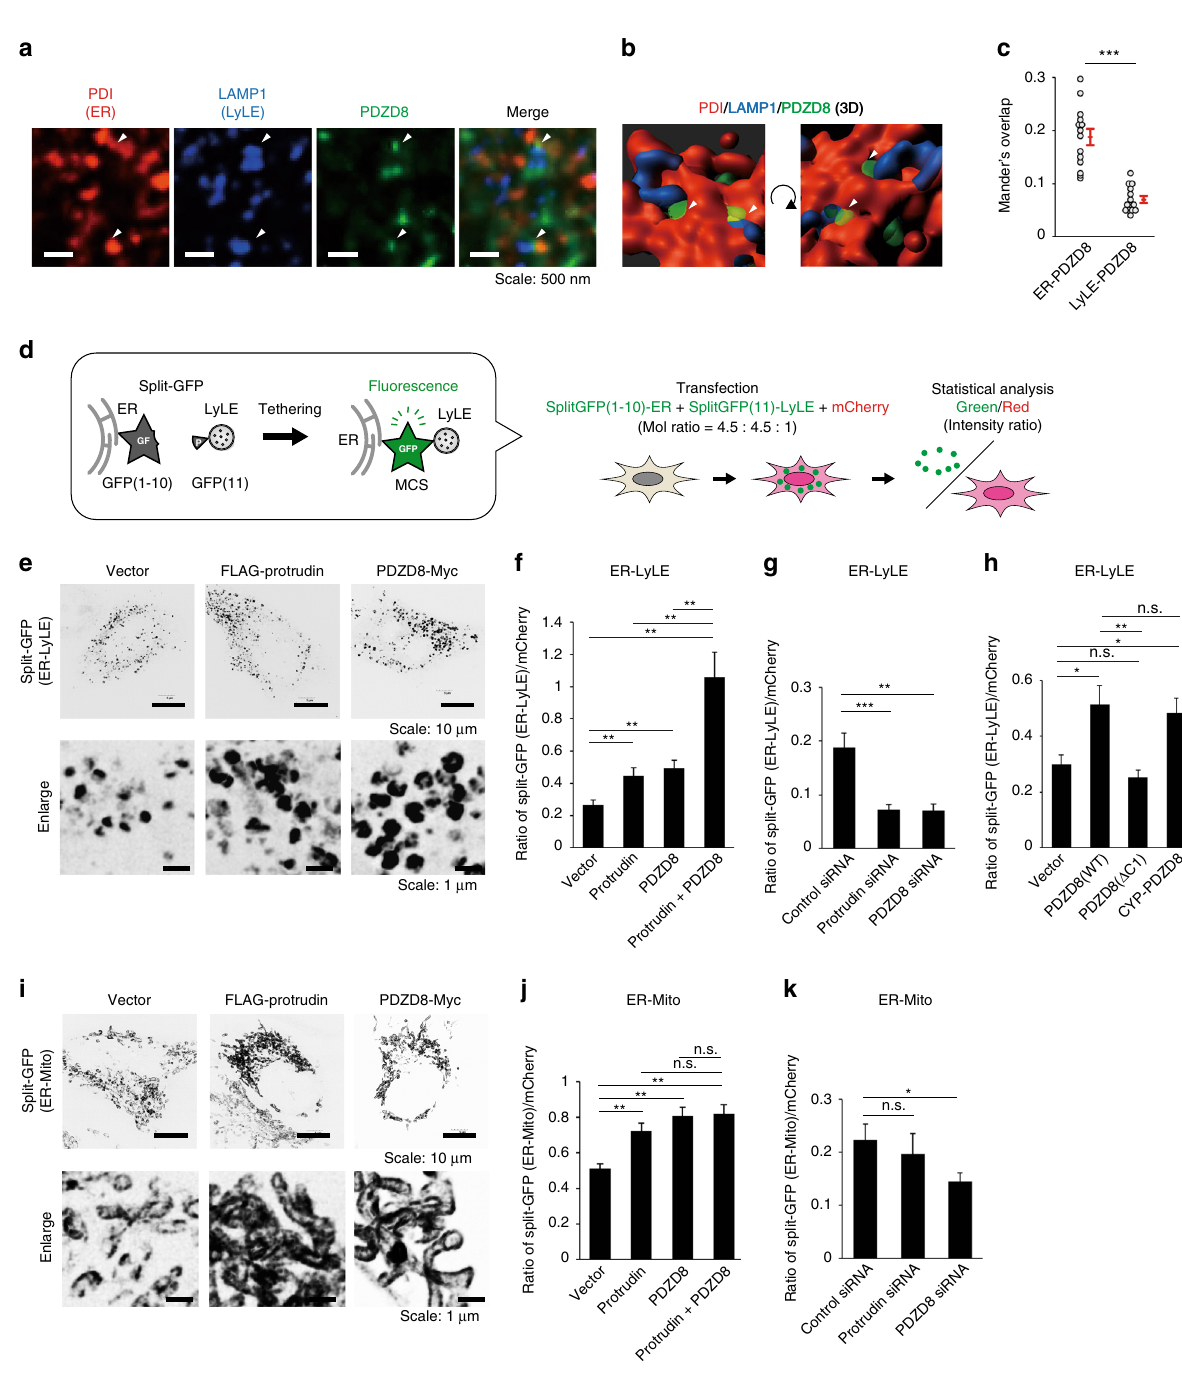
activity of GST-PDZD8 derivatives was determined from the measured fl uorescence intensity of NBD after subtraction of that observed in the presence of GST as a control (Supplementary Fig. 10a – c). Phospholipids — including phosphatidic acid (PA), phosphatidylserine (PS), phosphatidylethanolamine (PE), and phosphatidylcholine (PC) — were indeed extracted by PDZD8 ( Δ TM) (Fig. 3c), with the initial velocity of lipid extraction being greatest for PS (Fig. 3e and Supplementary Fig. 10d). PDZD8 ( Δ TM) also showed high extraction activity for ceramide and low extraction activity for cholesterol in terms of lipid extraction velocity (Fig. 3d, e and Supplementary Fig. 10d). Lipid transfer comprises two steps, lipid extraction from the donor membrane and its insertion into the acceptor